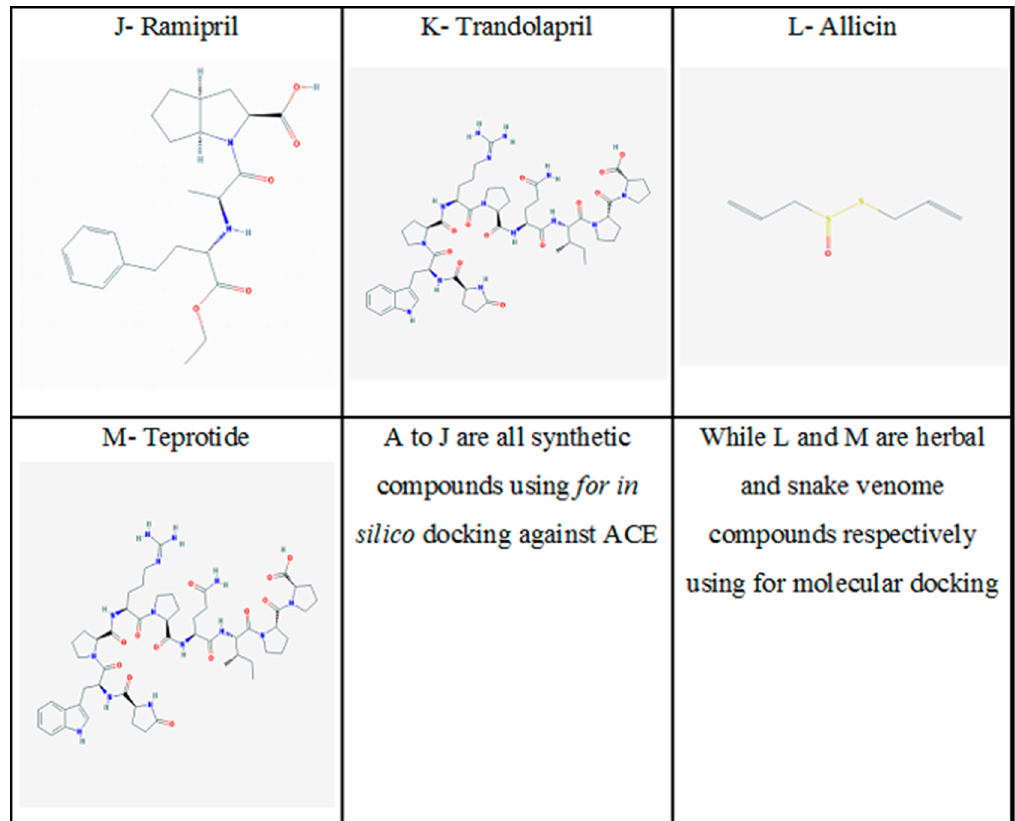
Figure 4. 2D structures of various ACE inhibitors including ( A ) Benazepril, ( B ) Captopril, ( C ) Cilazapril, ( D ) Enalapril, ( E ) Fosinopril, ( F ) Lisinopril, ( G ) Moexipril, ( H ) Perindopril, ( I ) Quinapril, ( J ) Ramipril, ( K ) Trandolapril, ( L ) Allicin, and ( M ) Teprotide. Table 5. Inhibitors ranked on the basis of their S-values.